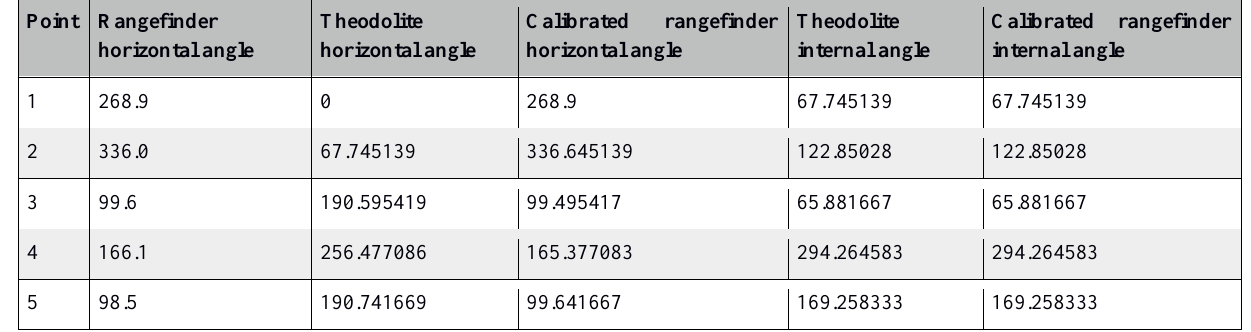
Table 3: Calibration of room 1 rangefinder horizontal angle measurements by homotopies (in decimal degrees).